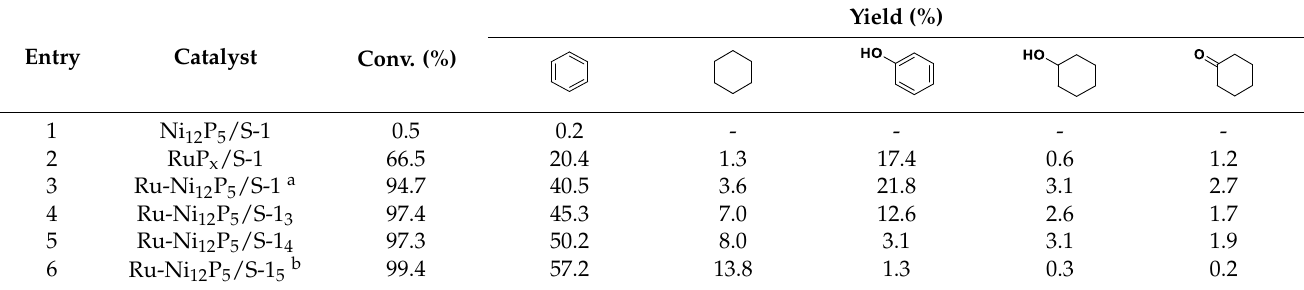
Table 2. Hydrogenolysis of diphenyl ether over different catalysts.